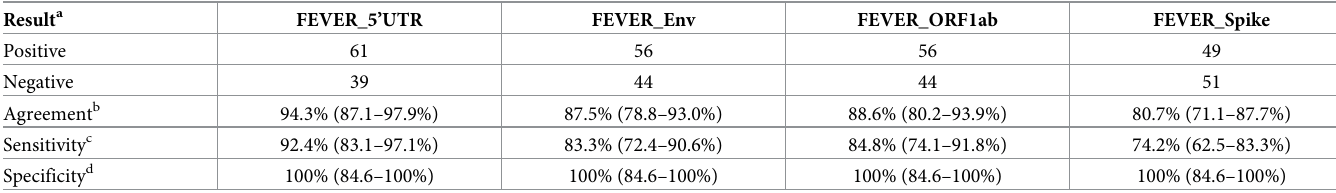
Table 4. FEVER assays compared to the U.S. CDC assays for detection of SARS-CoV-2 in 100 human patient nasopharyngeal swab samples. Result a